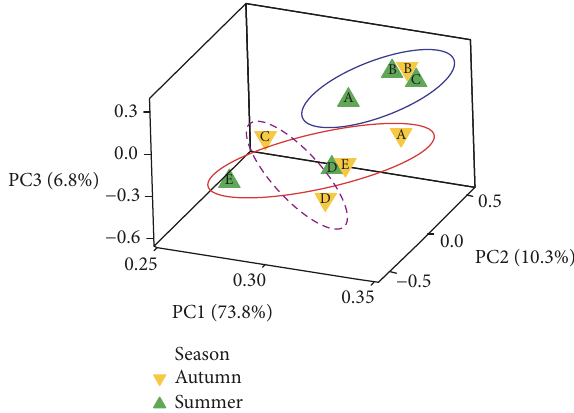
Figure 2: Principal Component Analysis for dairies and sampling period of Chihuahua cheese for sensory analysis. Scores of each sample for the three first Principal Component Analyses (PCA) are